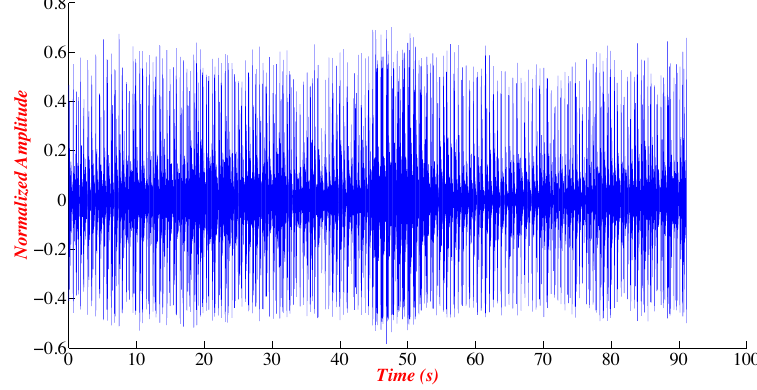
Figure 4. Synthetic audio signal after pre-processing